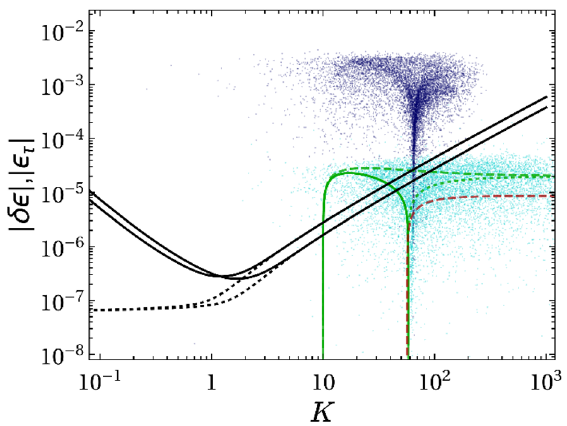
Figure 1 . Required j (cid:14)(cid:15) j (black) to explain the observed baryon asymmetry in the one (cid:13)avor regime and possible j (cid:15) (cid:28) j (colored) with CP (cid:22)(cid:28) symmetry, both as functions of K . Solid and dashed black lines refer to zero initial N 1 abundance and thermal initial N 1 abundance, respectively. The colored lines indicate the possible values for j (cid:15) (cid:28) j for hierarchical N i masses with M 1 = 10 12 GeV and decoupled N 3 for the cases of Normal Ordering, NO-(00)/(31) (solid green), NO-(12)/(23) (dashed green), NO- (13)/(22) (dotted green), and of Inverted Ordering, IO-(11)/(22) (dashed red). The nomenclature is from ref. [25] and refer to the CP parities. The case IO-(12)/(21) is very close to the dashed red line. The omitted line for the case IO-(00)/(33) is very narrow and only covers the bottom part of the red dashed line below 6 (cid:2) 10 (cid:0) 8 . Rescaling M 1 up will scale the lines proportionally up. The scattered points show random points (for all cases with CP (cid:22)(cid:28) and random lightest neutrino mass) without the assumption of hierarchical N i for M 1 = 10 12 GeV (cyan) and M 1 = 10 14 GeV (dark blue). 3 (cid:27) ranges from ref. [21] were used for the neutrino mixing parameters (cid:18) 12 ; (cid:18) 13 not (cid:12)xed by CP (cid:22)(cid:28) and neutrino mass squared di(cid:11)erences. We include the one-loop corrections as discussed in the section